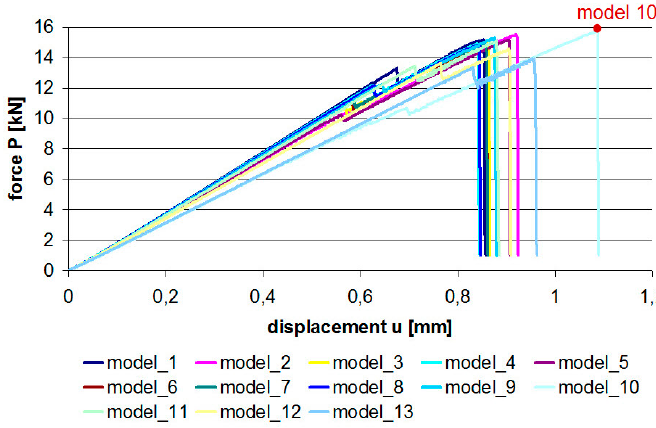
Figure 6. Force–displacement graphs for hybrid joints.